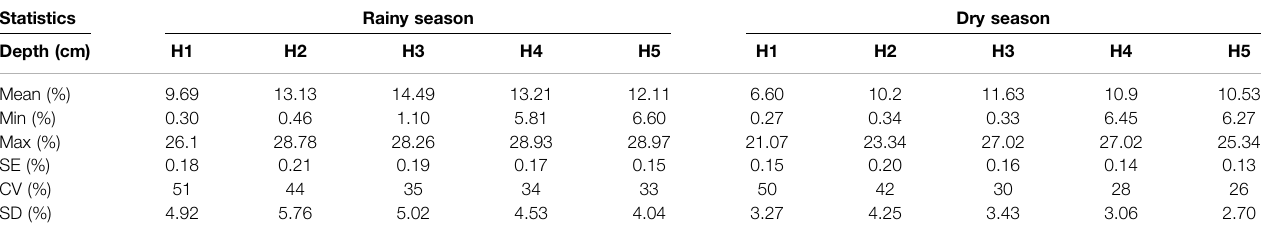
TABLE 2 | Statistical characteristics of SWC at different soil depths during rainy and dry seasons.